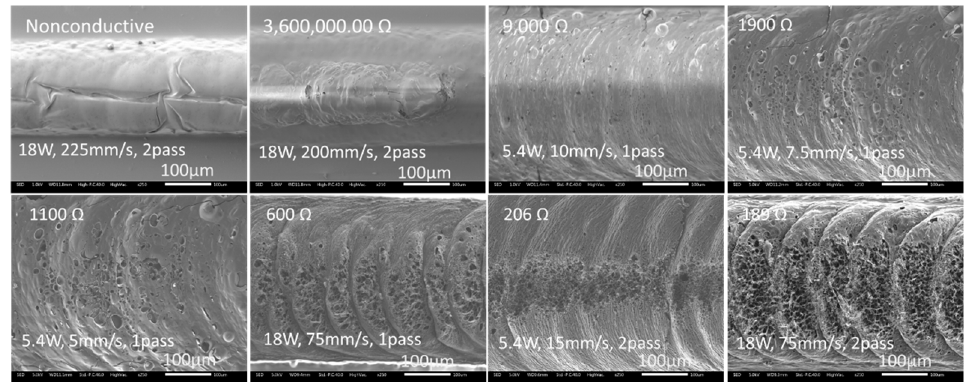
Figure 6. SEM images showing the polyimide morphology after laser irradiation (scanning from left to right in the images). It is to be expected that with an increase in irradiation energy dose per unit length through an increase in laser power from 5 W to 30 W and a decrease in scanning speed from 450 mm/s to 5 mm/s, there was an obvious increase in irradiation line width as shown in Figure 7. This is because the laser–polyimide interaction was enhanced under a high energy dose per unit length, i.e., at high power with longer interaction time. Indeed, rather independent of the individual change in laser power or scanning speed, the line width produced under similar energy dose per unit length per pass would be similar, either scan one pass or two passes. At low energy dose per unit length at low laser power, only the tip of the gaussian beam had sufficient energy to induce modification of polyimide surface. Therefore, the line width was much less than one spot width (diameter) at this low energy dose. The line width would increase with an increase in energy dose per unit length and laser power. However, with sufficiently high laser power, this increase in line width would become less sensitive with an increase in laser power. Indeed, the critical role of laser power in addition to energy dose per unit length is highlighted by the relatively narrower line width at the lower laser power of 5.0 W despite of the same or higher energy dose per unit length as compared to that at higher laser power, see Figure